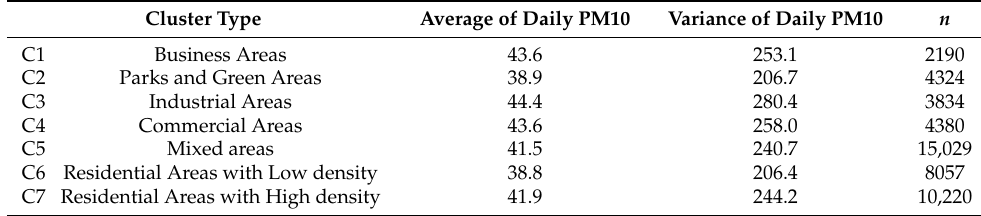
Table 4. Differences in PM10 concentration and variability by